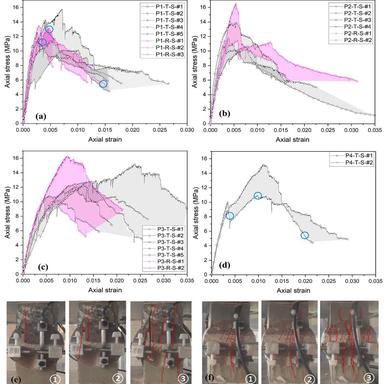
Axial stress versus axial strain under compression for single-wythe cores extracted from: P1(a), P2(b), P3(c) and P4(d); the evolution of crack pattern for core P1-R-S-#2 (e) and P4-T-S-#2 (f).